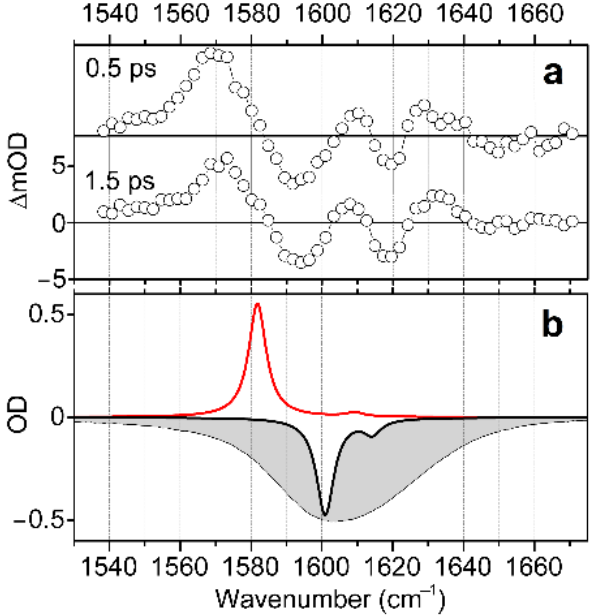
Figure 6. ( a ) Induced IR spectra detected at 0.5 and 1.5 ps time-delays after visible pulsed excitation of d-d transitions at 600 nm. ( b ) Negative FTIR spectrum (grey filled profile), negative calculated IR response of the trans -H structure optimized in the ground electronic state (black line), and calculated IR response of trans -H structure optimized in the first excited electronic state (red line). The calculated IR responses are expressed using convolution with a narrow line-shape for the purpose of clarity, as in Figure 2c .